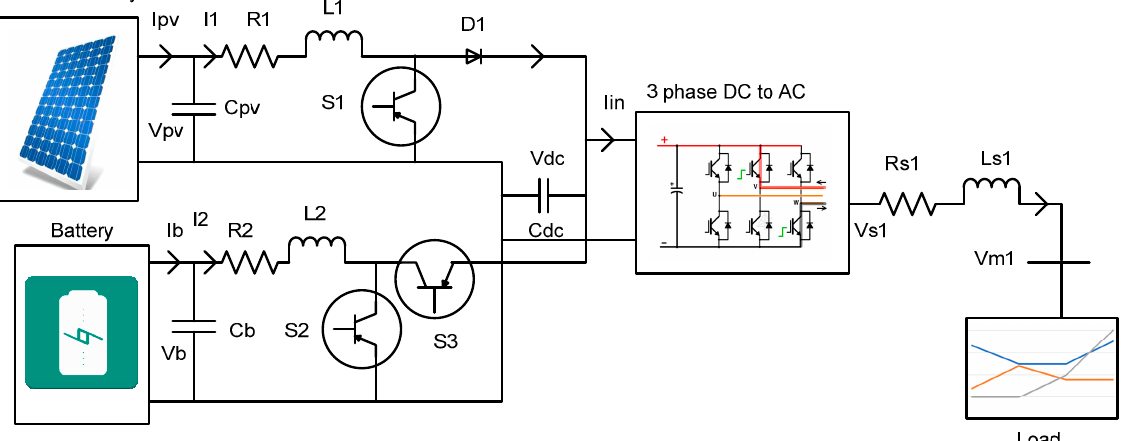
Figure 4. Schematic diagram of PV with Battery inverter system.